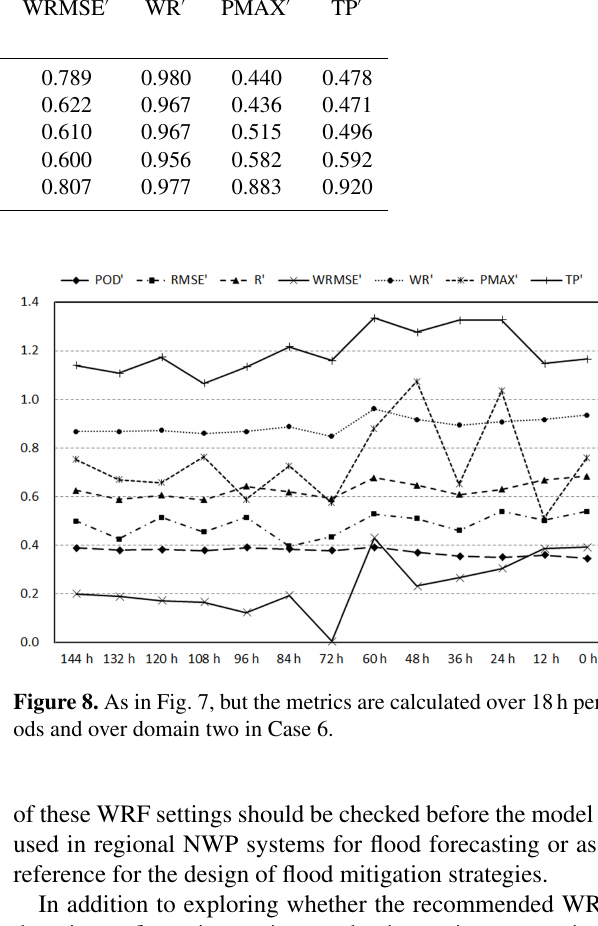
Table 3. Comparison of the values of the error metrics in the initial experiment and the optimum experiments identified for each scenario. Experiment